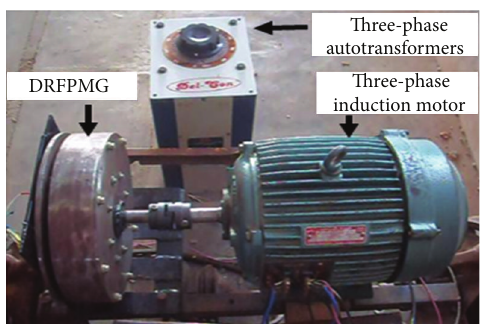
Figure 14: Experimental setup.